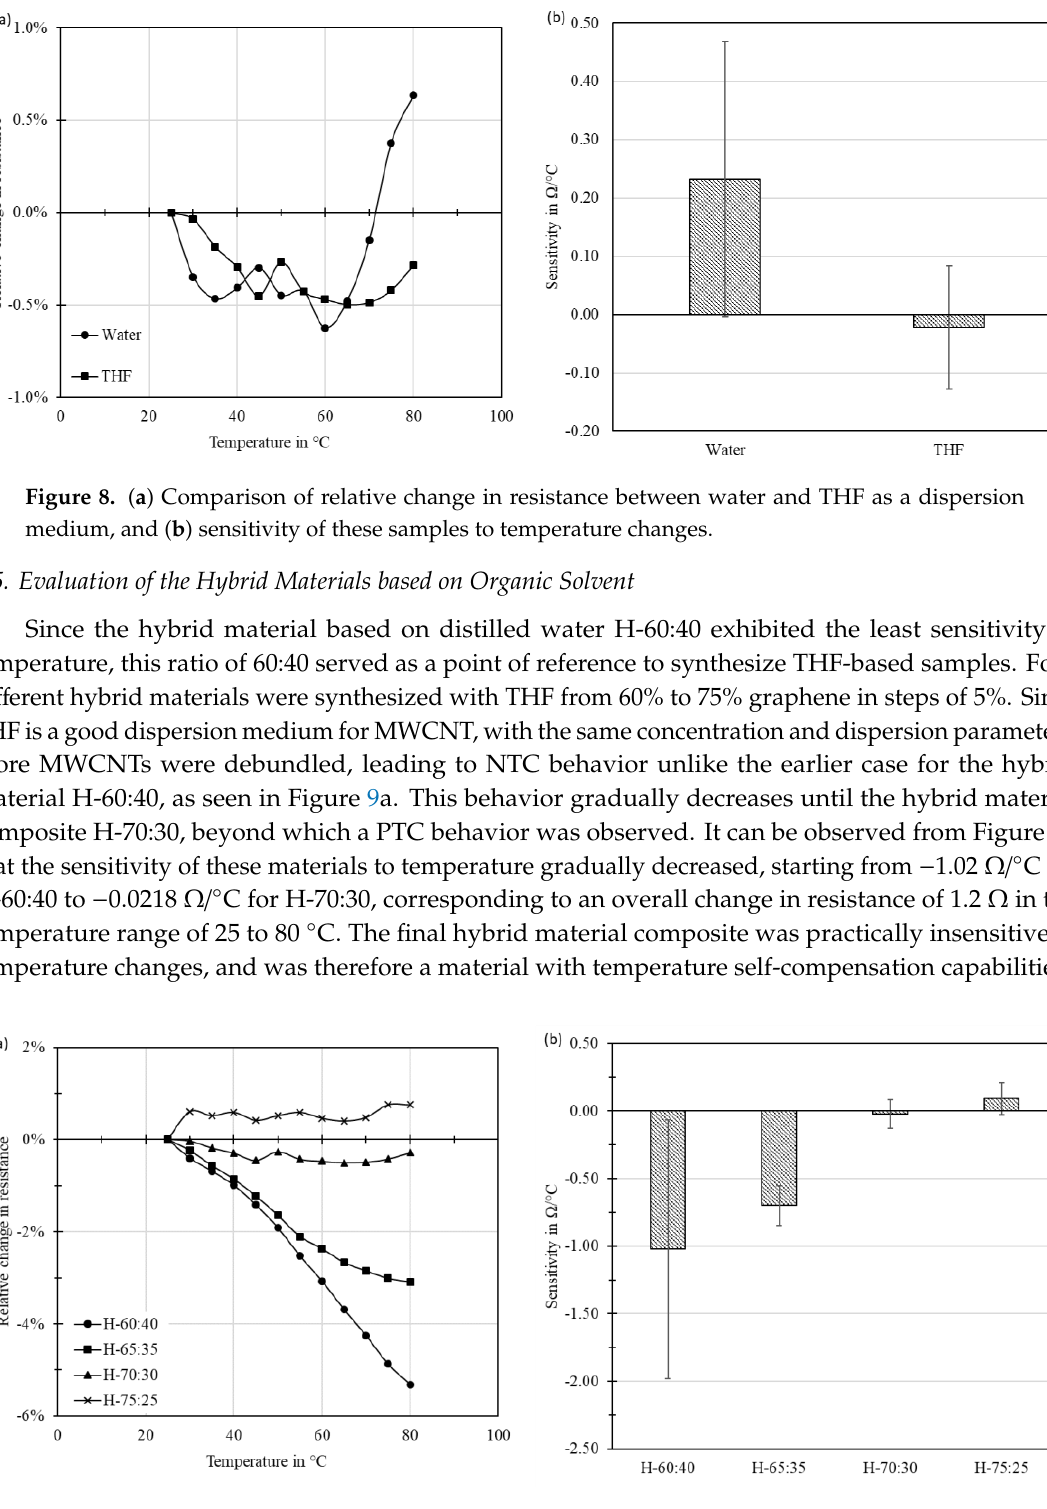
Figure 9. ( a ) Relative change in resistance with temperature for different hybrid samples with THF as a dispersion medium, and ( b ) sensitivity of these samples to temperature changes.